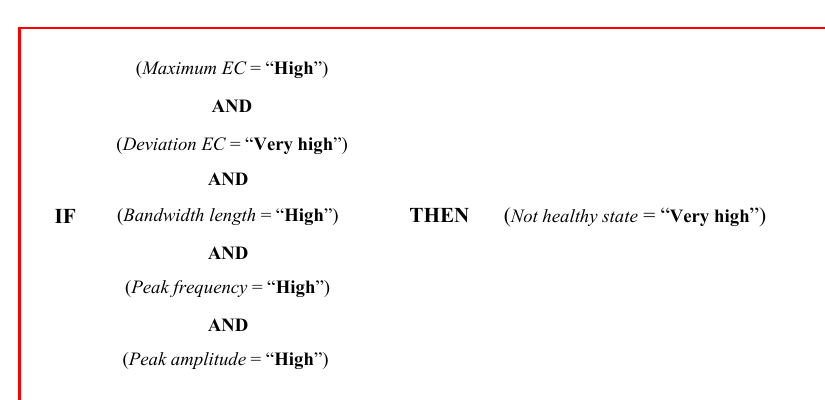
Figure 3. Example of a rule used in the fuzzy inference .